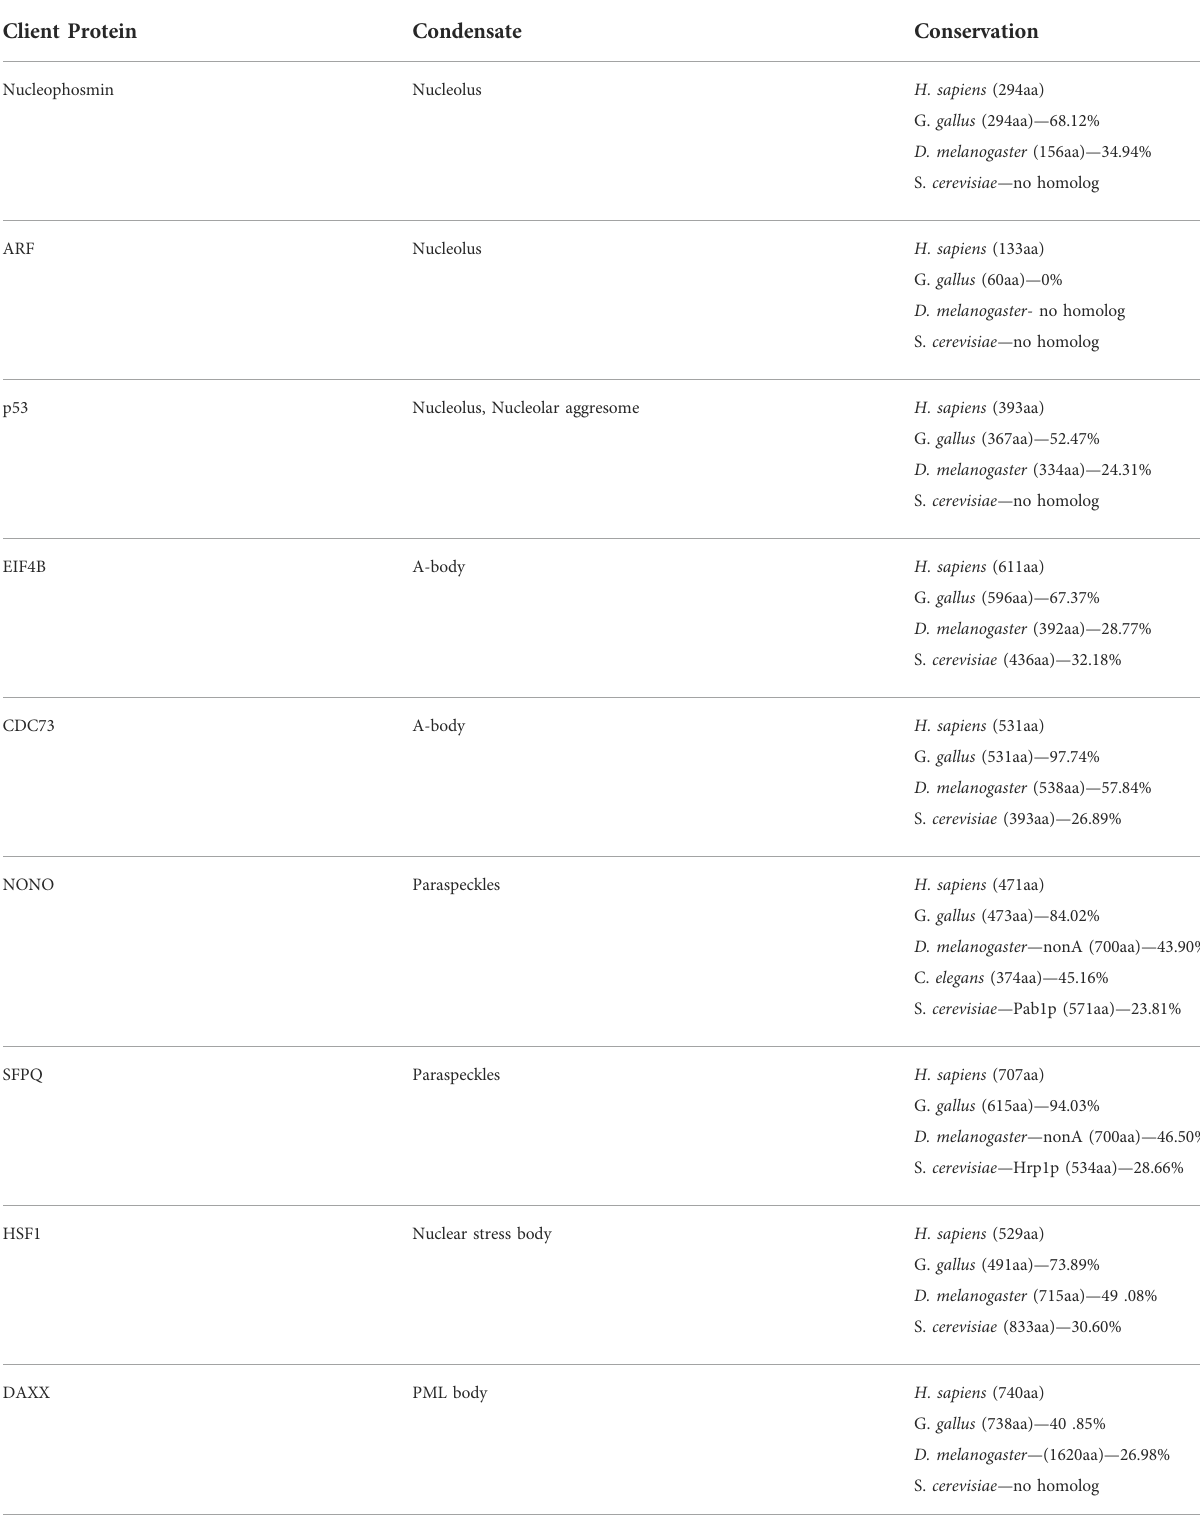
TABLE 2 A comparison of eukaryotic client proteins of nuclear biomolecular condensates. Percentage of alignments were generated using NCBI protein or nucleotide BLAST alignment